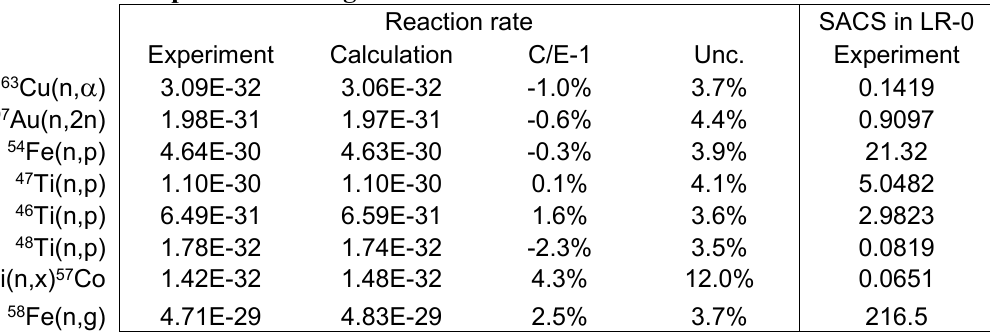
Table II. Evaluated reaction rates in LR-0 spectrum normalized to unit core emissivity and experimental LR-0 spectrum averaged cross